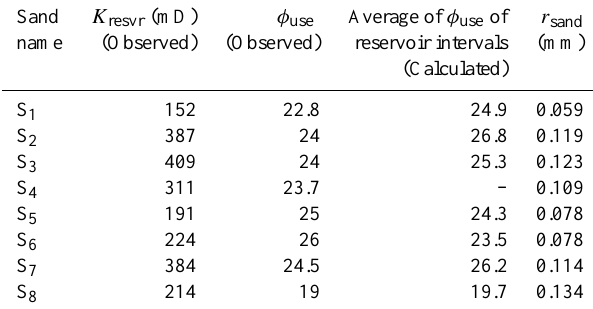
Table 3. The observed average useful porosity, observed average reservoir permeability ( k resvr ) , calculated average useful porosity of reservoir intervals and estimated grain radius for different sand layers in the formation.